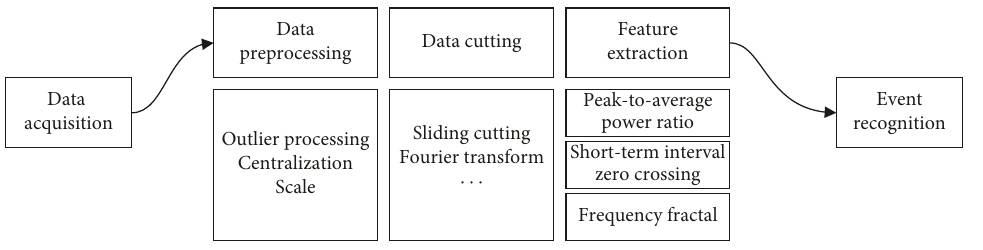
Figure 3: Diagram of the hybrid feature extraction